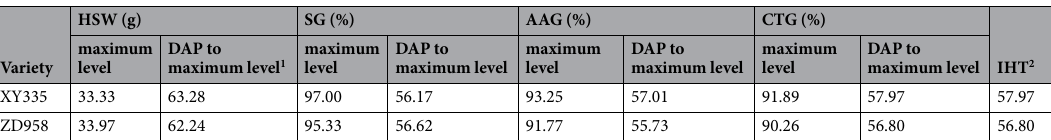
Table 3. Maximum values of hundred-seed weight (HSW), standard germination (SG), accelerated aging germination (AAG) and cold test germination (CTG), and the corresponding days from pollination to the predicted date for achieving maximum levels in XY335 and ZD958 across 8 environments. 1 The corresponding DAP (days after pollination) indicate days from pollination to the predicted dates at which the maximum level of each trait will be reached. 2 IHT, the ideal harvest time, the last date to achieve maximum SG, AAG and